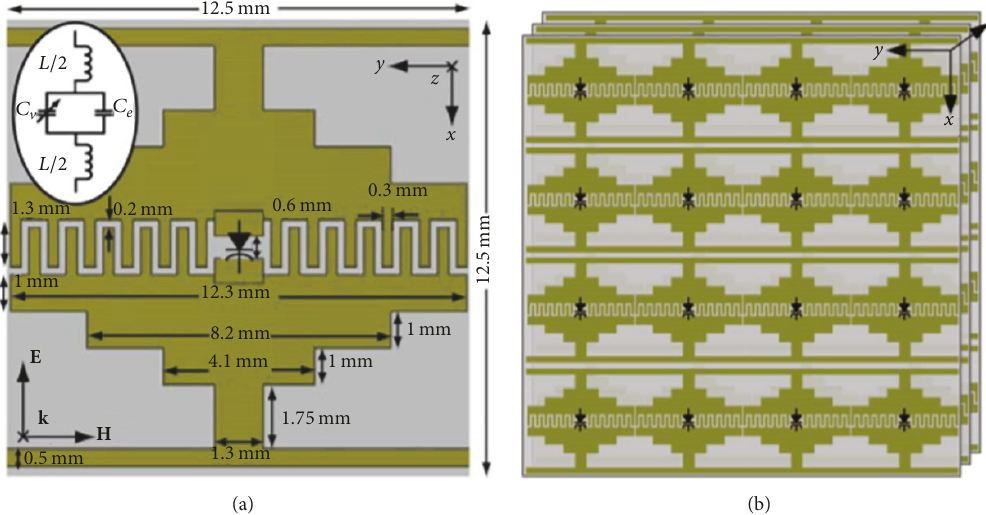
Figure 16: (a) Unit-cell of the realized metamaterial and its equivalent circuit; (b) metamaterial structure as a combination of unit-cells. The operating frequency is 4.7 GHz